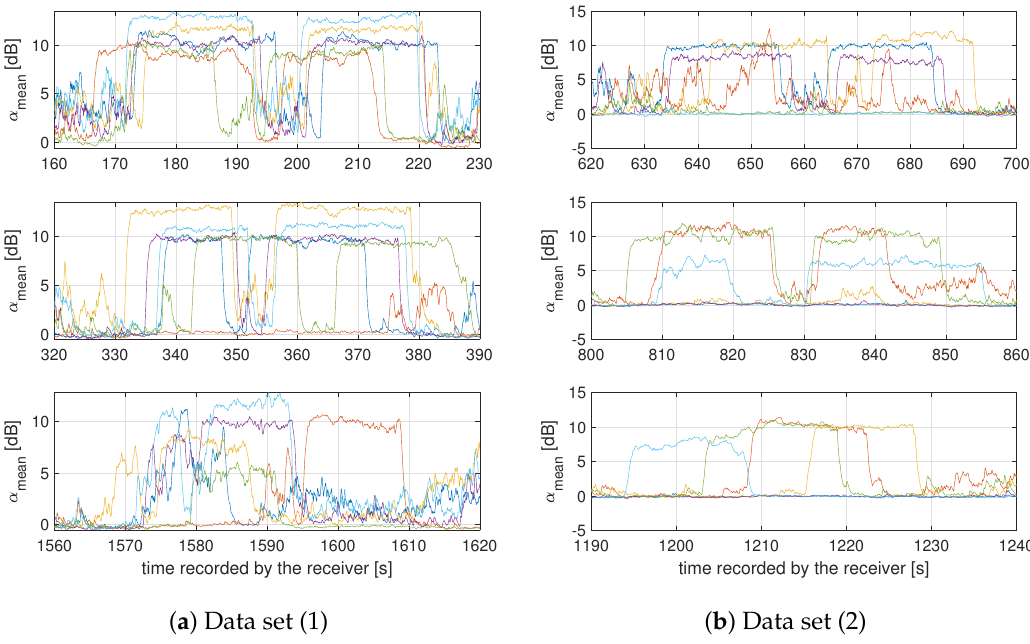
Figure 5. Comparison of the peak-to-noise-floor separation of the reflected signal for ( a ) data set (1), and ( b ) data set (2), when the sensor crossed the lakes on the different passes: north to south ( top ), south to north ( middle ), and west to east ( bottom